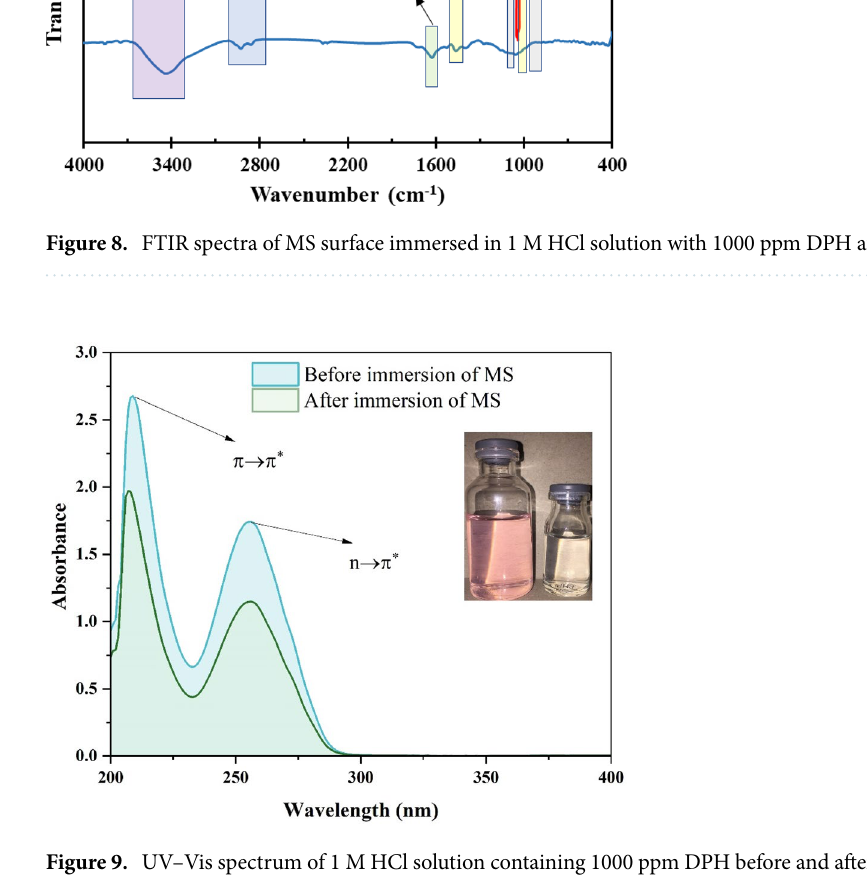
Figure 9. UV–Vis spectrum of 1 M HCl solution containing 1000 ppm DPH before and after 12 h immersion of